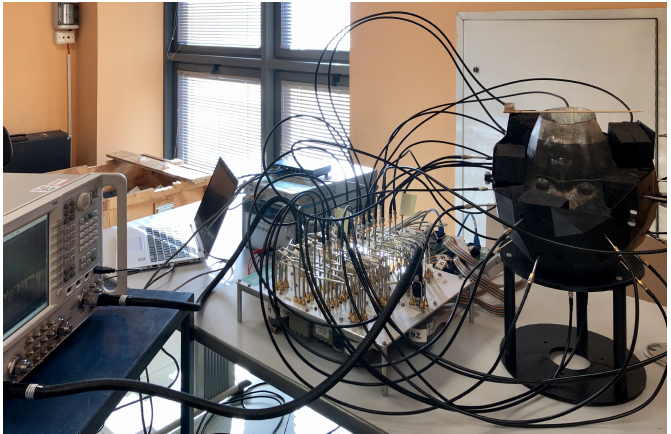
Figure 1. Overview of the realized 3D microwave imaging system prototype. From left to right: vector network analyzer (VNA), switching matrix and head phantom wearing a helmet interconnected to the switching matrix by means of coaxial